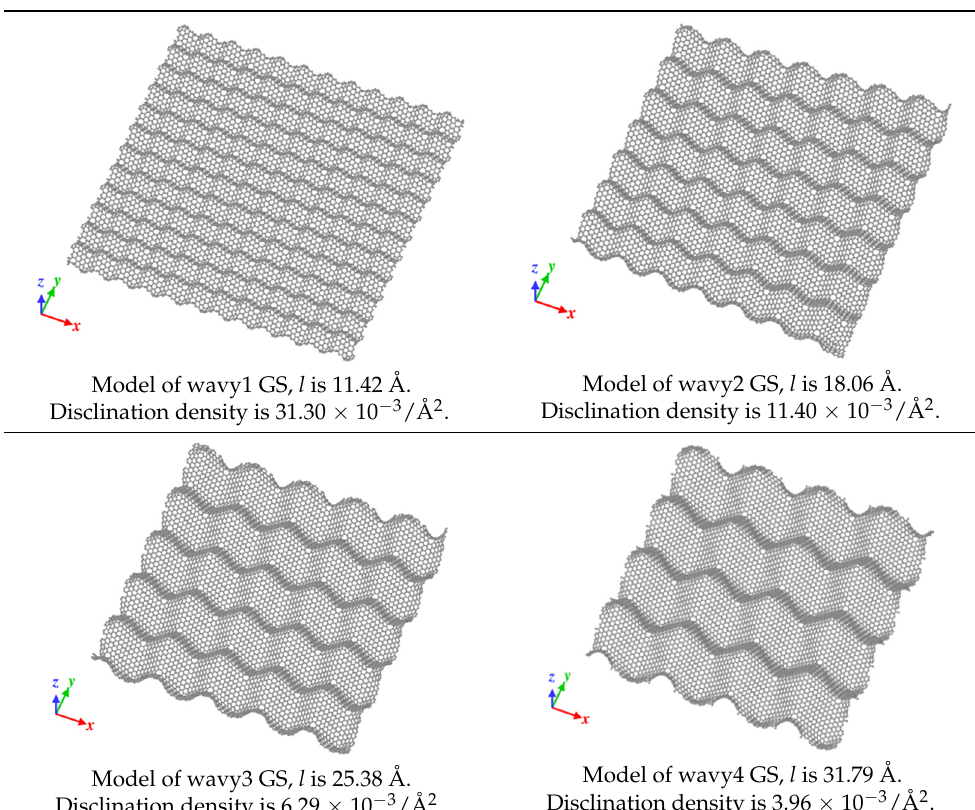
Table 1. Parameters of the four types of wavy GSs.